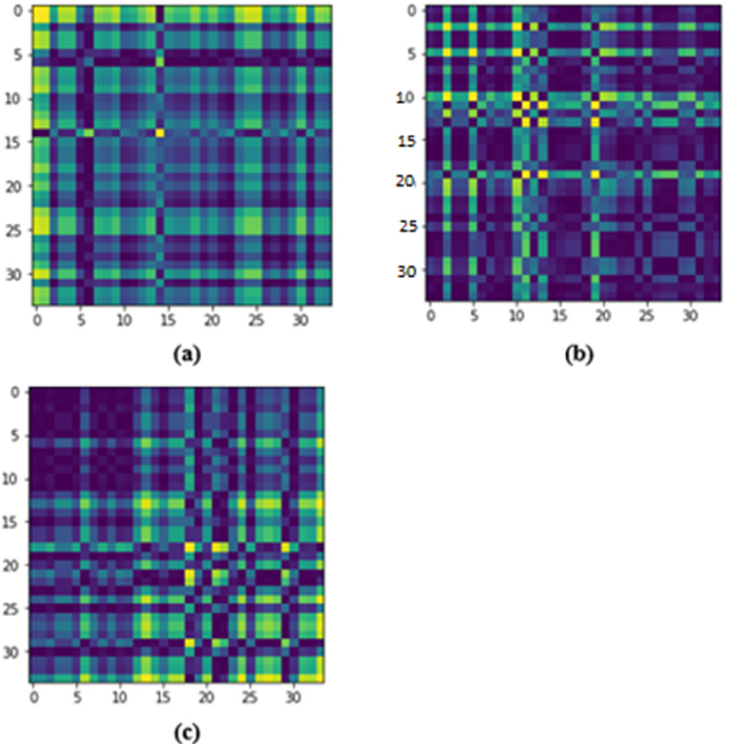
Figure 3. Illustration of random GAF images transformed from the normalized SWELL dataset: ( a ) level 0 (No Stress), ( b ) level 1 (Time Pressure), ( c ) level 2